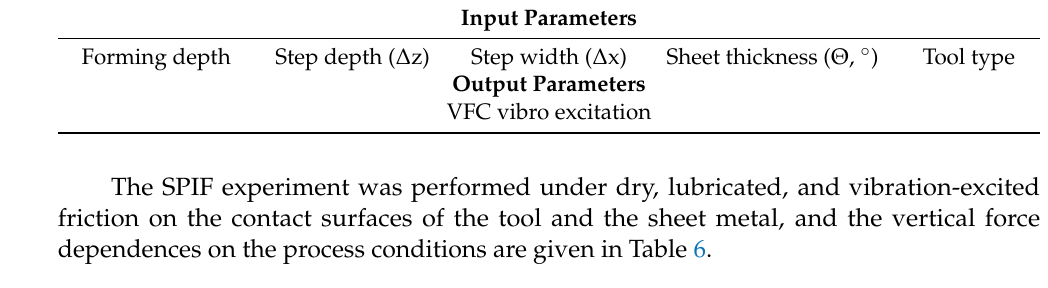
Table 6. Vertical force dependence from different friction when sheet thickness is 0.5